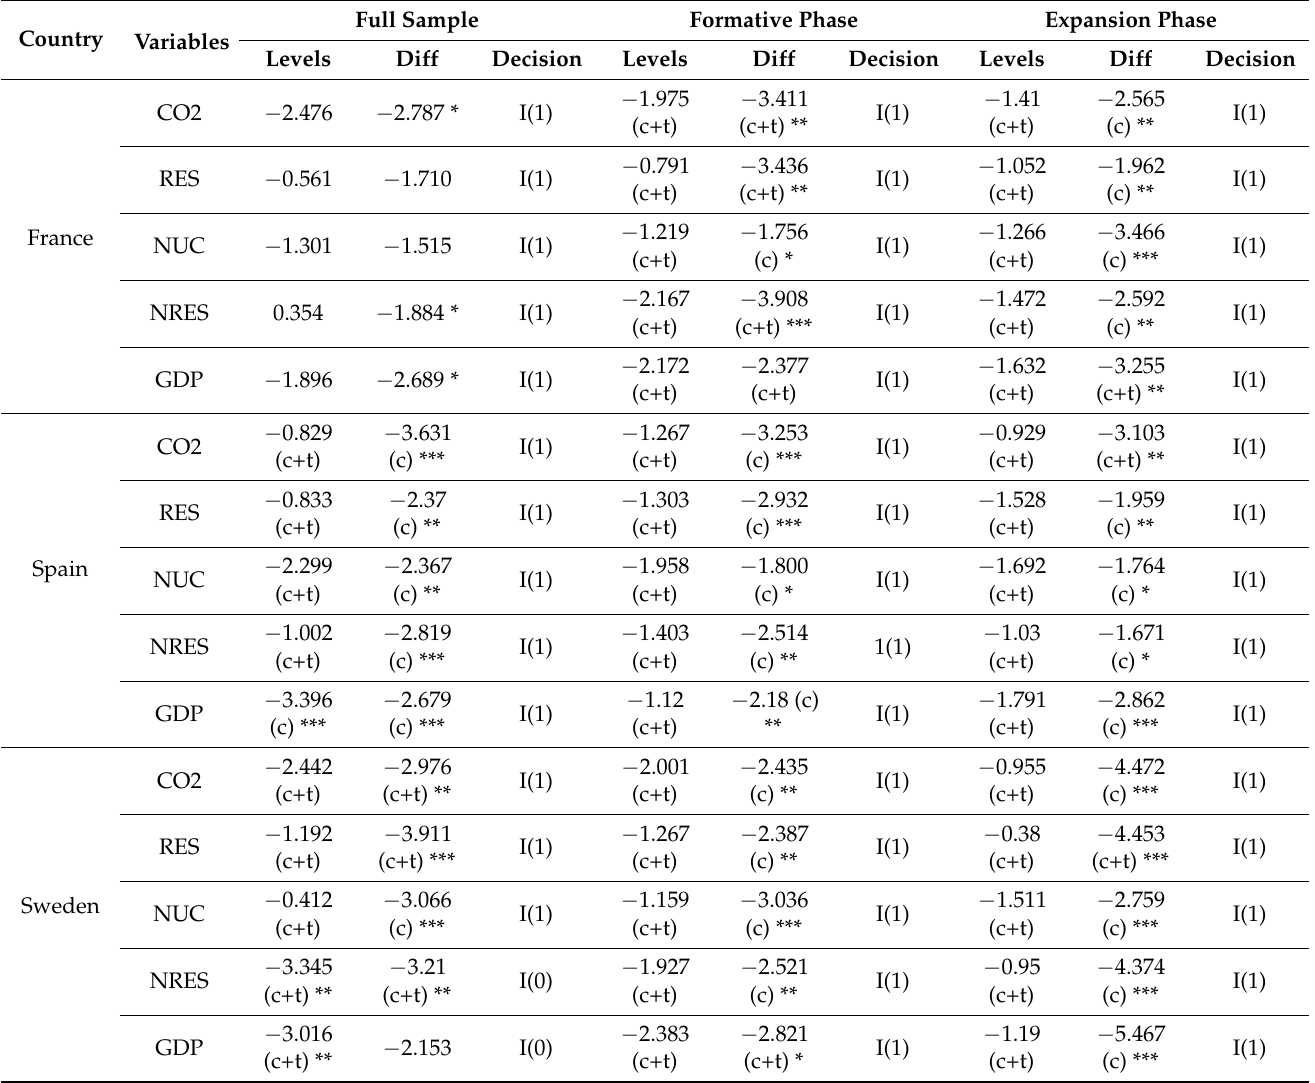
Table A1. Unit root test results (ADF-GLS).